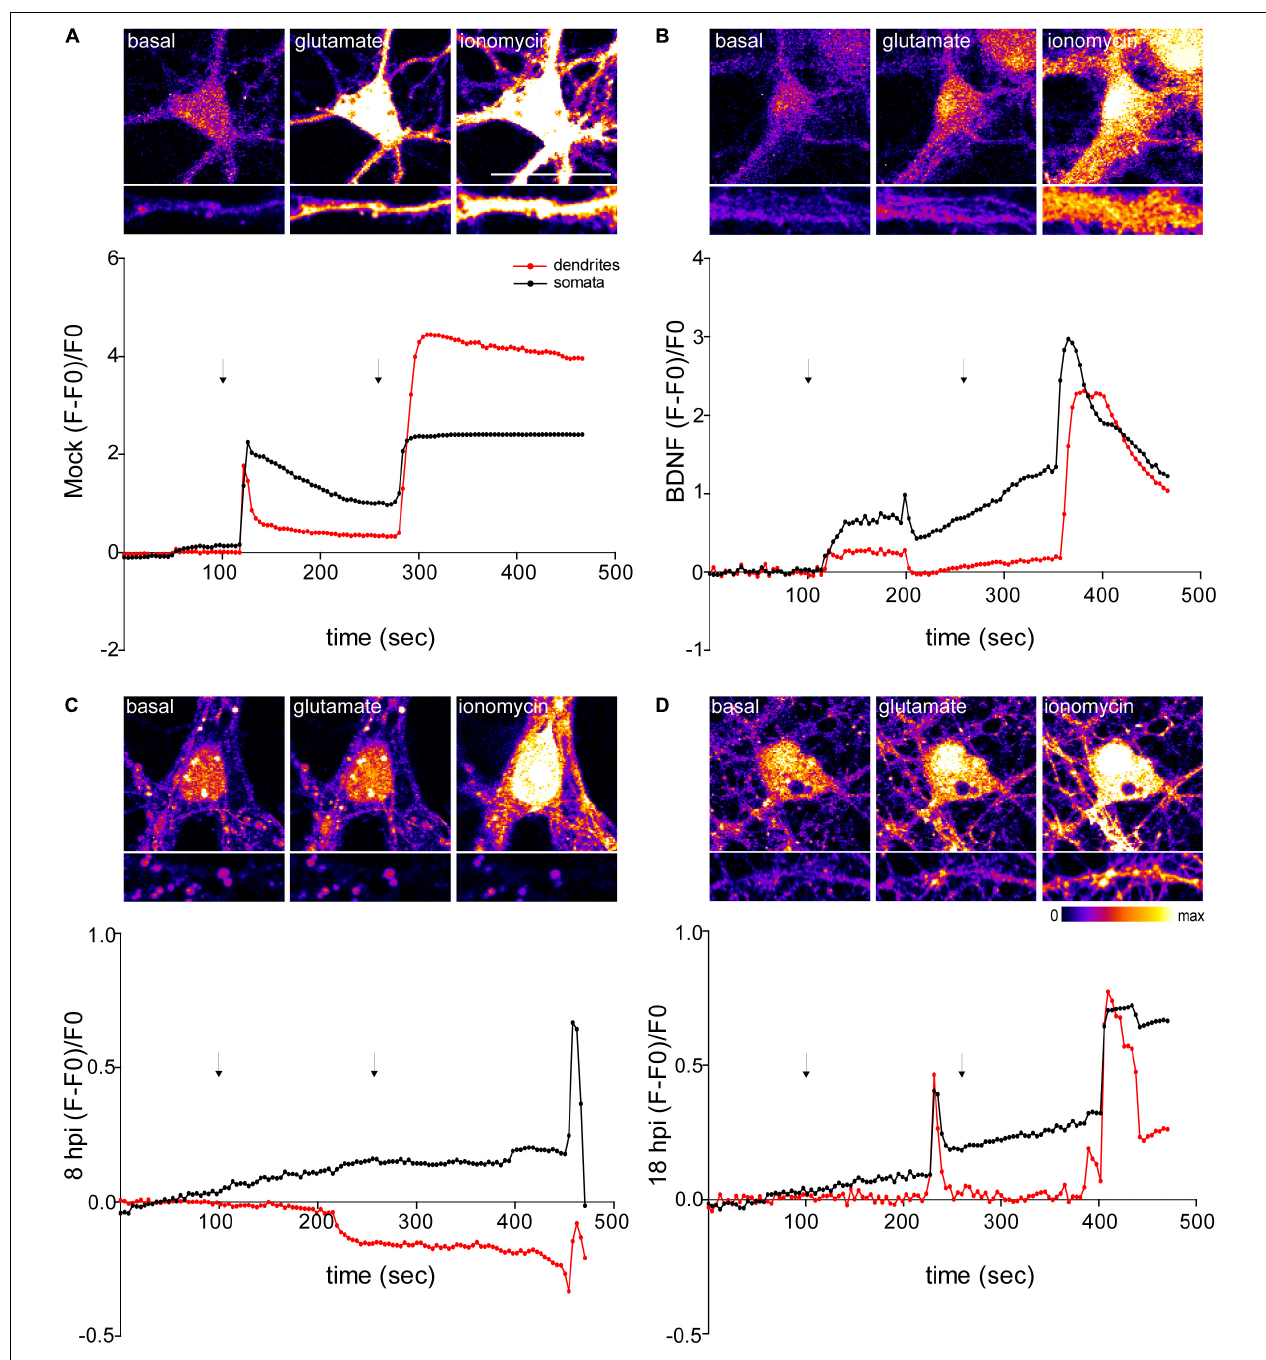
FIGURE 6 | Infected neurons show an impaired response to glutamate stimulation. Top panels show representative microscopy images of somata and dendrites. (A) Mock-infected, (B) BDNF-treated and HSV-1-infected neurons at 8 and 18 hpi, respectively ( C and D ). Variations of relative cytosolic Ca 2 + concentrations were monitored by fluorescence in Fluo4-loaded cortical neurons. The first arrow indicates the addition of glycine plus glutamate. The second arrow indicates the addition of the positive control ionomycin. The data is representative of traces of three independent experiments.